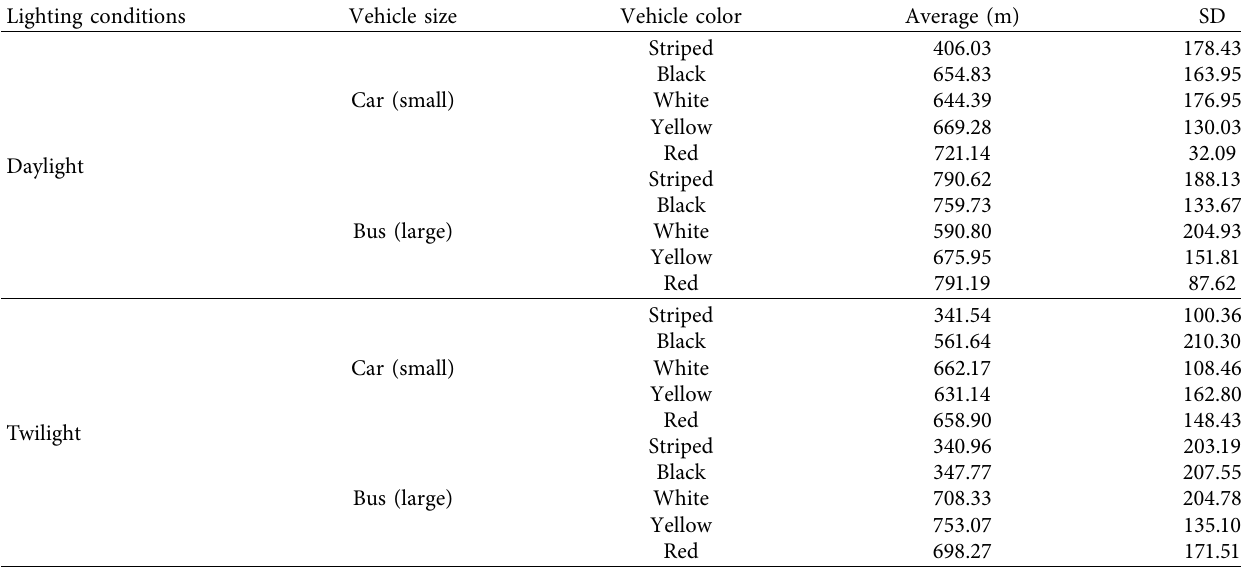
Table 1: Descriptive statistics for the front identification distance.